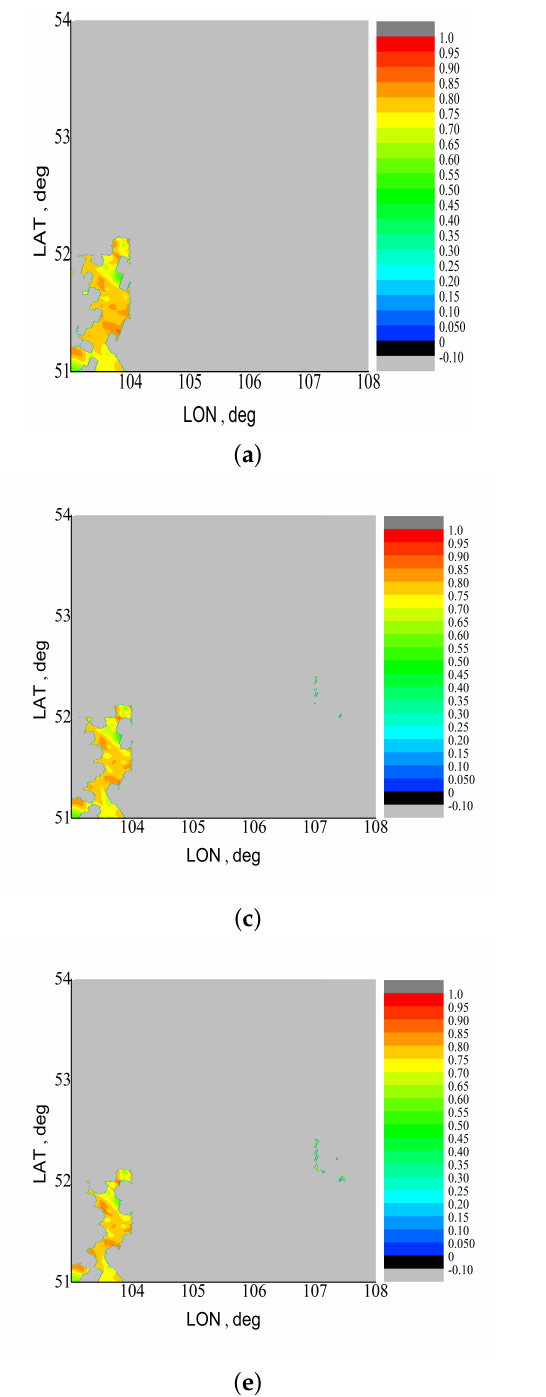
Figure 7. Ground surface reflectances for the considered region at 05:00 UTC of 2 July 2021, from MOD09 data after rejection of pixels with strong CAE: ( a ) MODIS band 8, ( b ) MODIS band 3, ( c ) MODIS band 4, ( d ) MODIS band 1, and ( e ) MODIS band 2. The values from 0 to − 0.1 correspond to the negative surface reflectance according to MOD09 data. The values smaller than − 0.1 correspond to areas covered by clouds or with strong